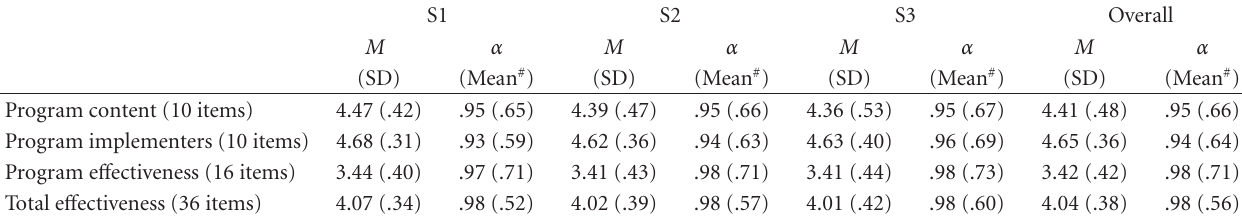
Table 4: Means, standard deviations, Cronbach’s alphas, and means of interitem correlations among the variables by grade.